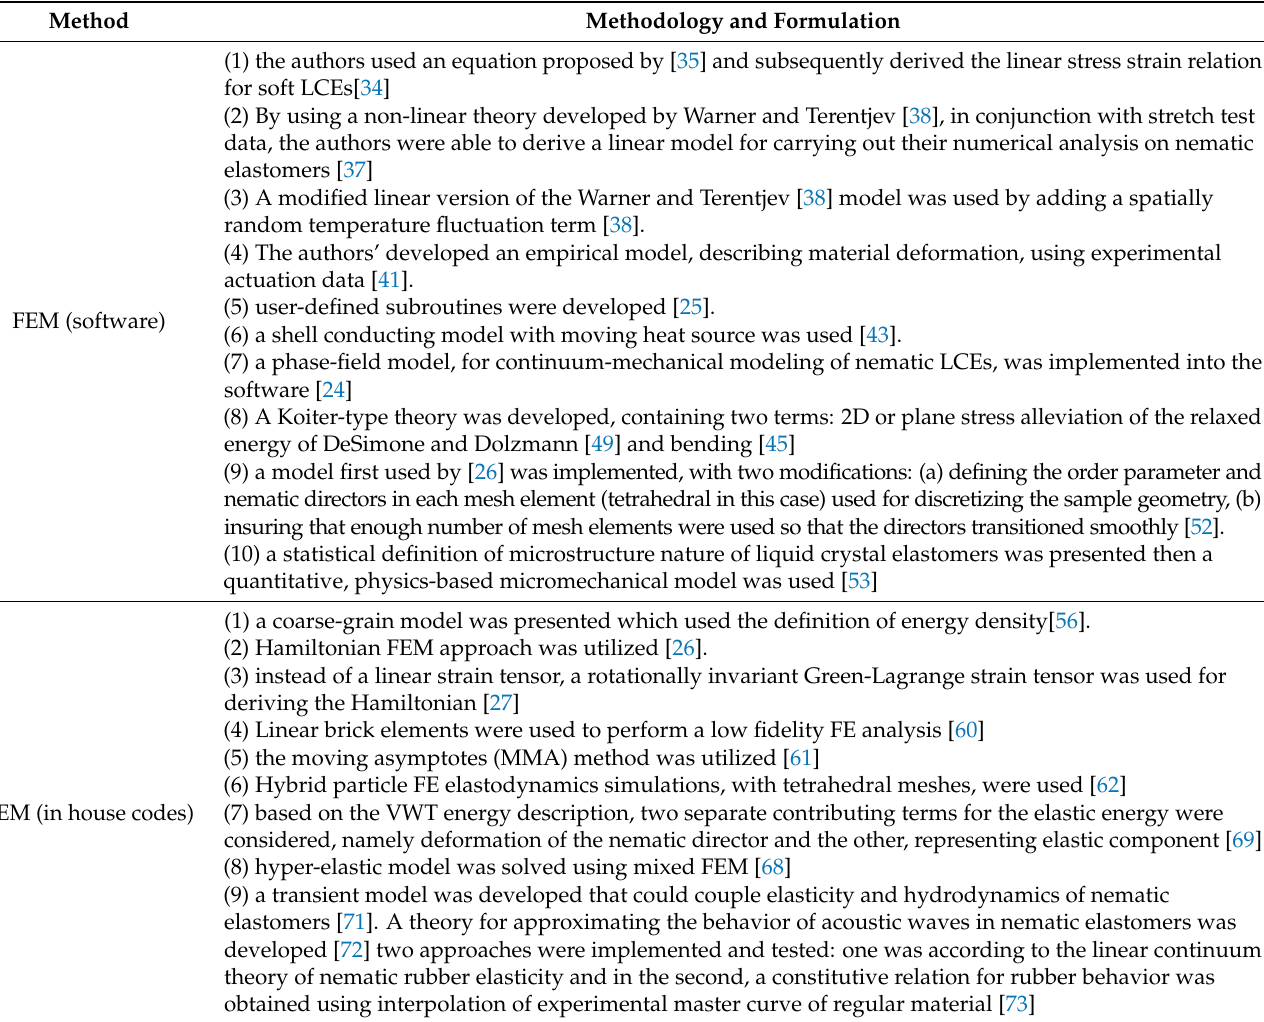
Table 2. Categorization of the reviewed numerical